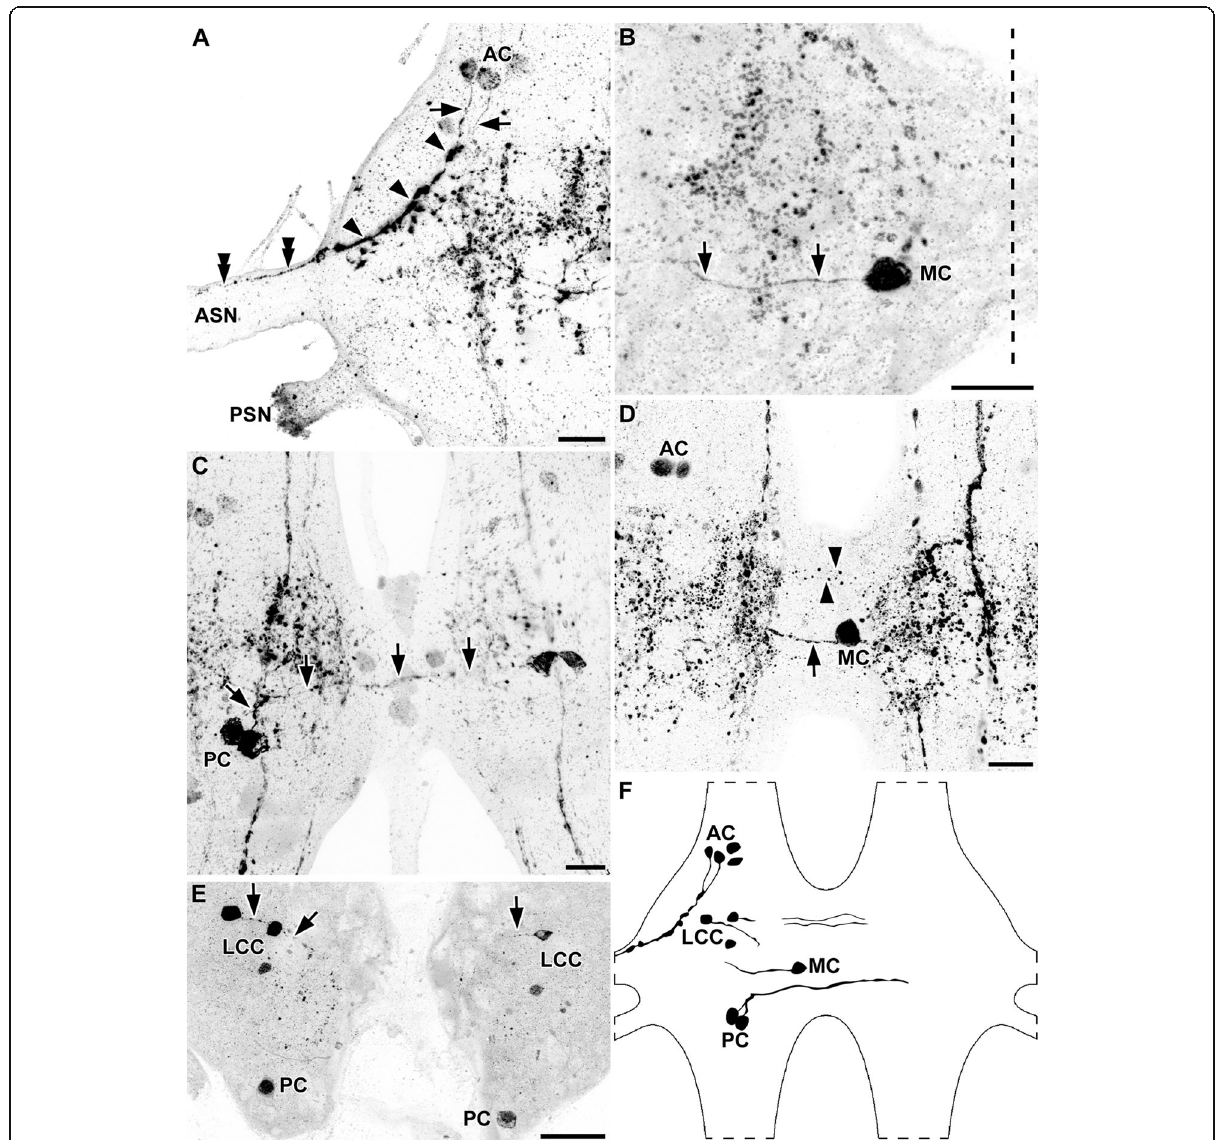
Fig. 5 Morphology of primary neurites of histaminergic neurons in the ventral nerve cord of Xibalbanus tulumensis . Maximum projections of cLSM stacks (ventral view, anterior to the top). a At least two somata of the cluster of anterior cell bodies (AC) sent neurites (black arrows) into an elongated granular-structured region (black arrowheads), which is associated to the ipsilateral anterior segmental nerve (ASN) (black double arrowheads). b The medial cell bodies (MC) projected laterally toward the center of the ipsilateral hemiganglion (ganglionic midline indicated by dashed line). c The primary neurites of the posterior cell bodies (PC) projected anteromedially and crossed the midline. These neurites could be traced to the center of the contralateral hemiganglion until the signal was lost. d Besides the rather strongly immunoreactive posterior commissure (black arrow) originating in the PC, two faintly labeled contralateral axons could be identified anteriorly (black arrowheads). e Short medial projections associated to the laterocentral cell bodies could be identified (black arrows). f Reconstruction drawings of selected histaminergic neurons in a ganglion of the ventral nerve cord. Abbreviations: AC: anterior cell bodies; ASN: anterior segmental nerve; LCC: laterocentral cell bodies; MC: medial cell bodies; PC: posterior cell bodies; PSN: posterior segmental nerve. Scale bars: a – e: 25 μ